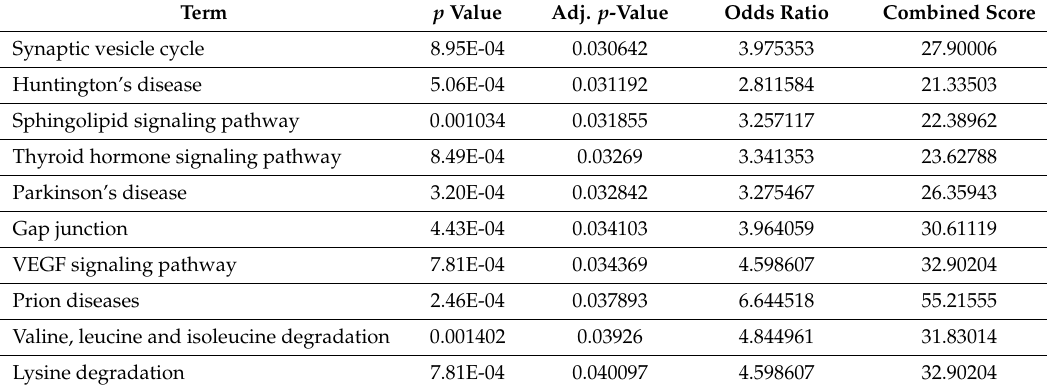
Table 2. Top 10 enriched KEGG pathways in brain samples from ASD